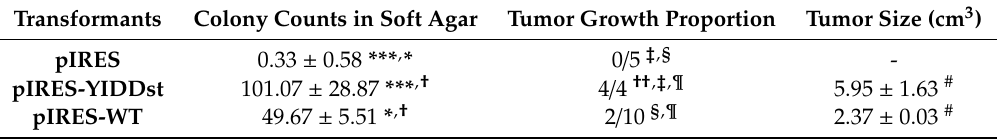
Table 1. Anchorage-independent growth and xenograft tumorigenesis in NIH3T3 transformants. Transformants Colony Counts in Soft Agar